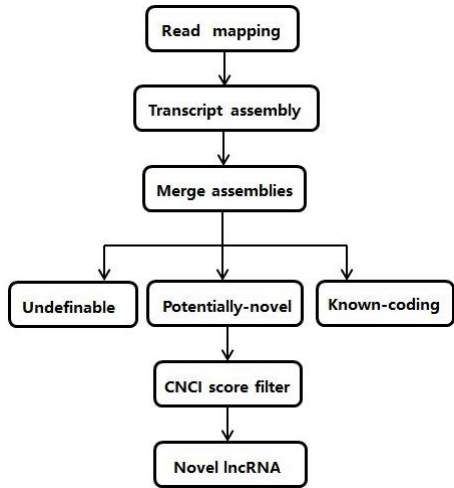
Figure 1. Pipeline to identify lncRNAs from RNA- seq data.